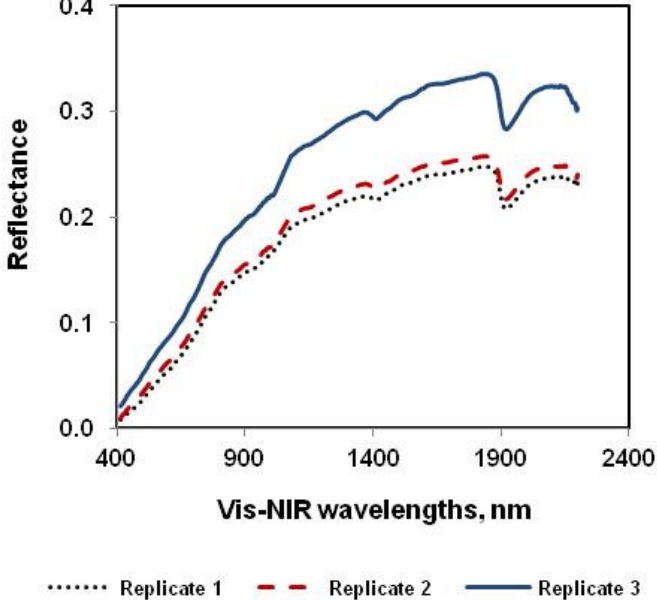
Figure 1. Differences in ex situ soil spectra when measured on the same soil sample thrice.